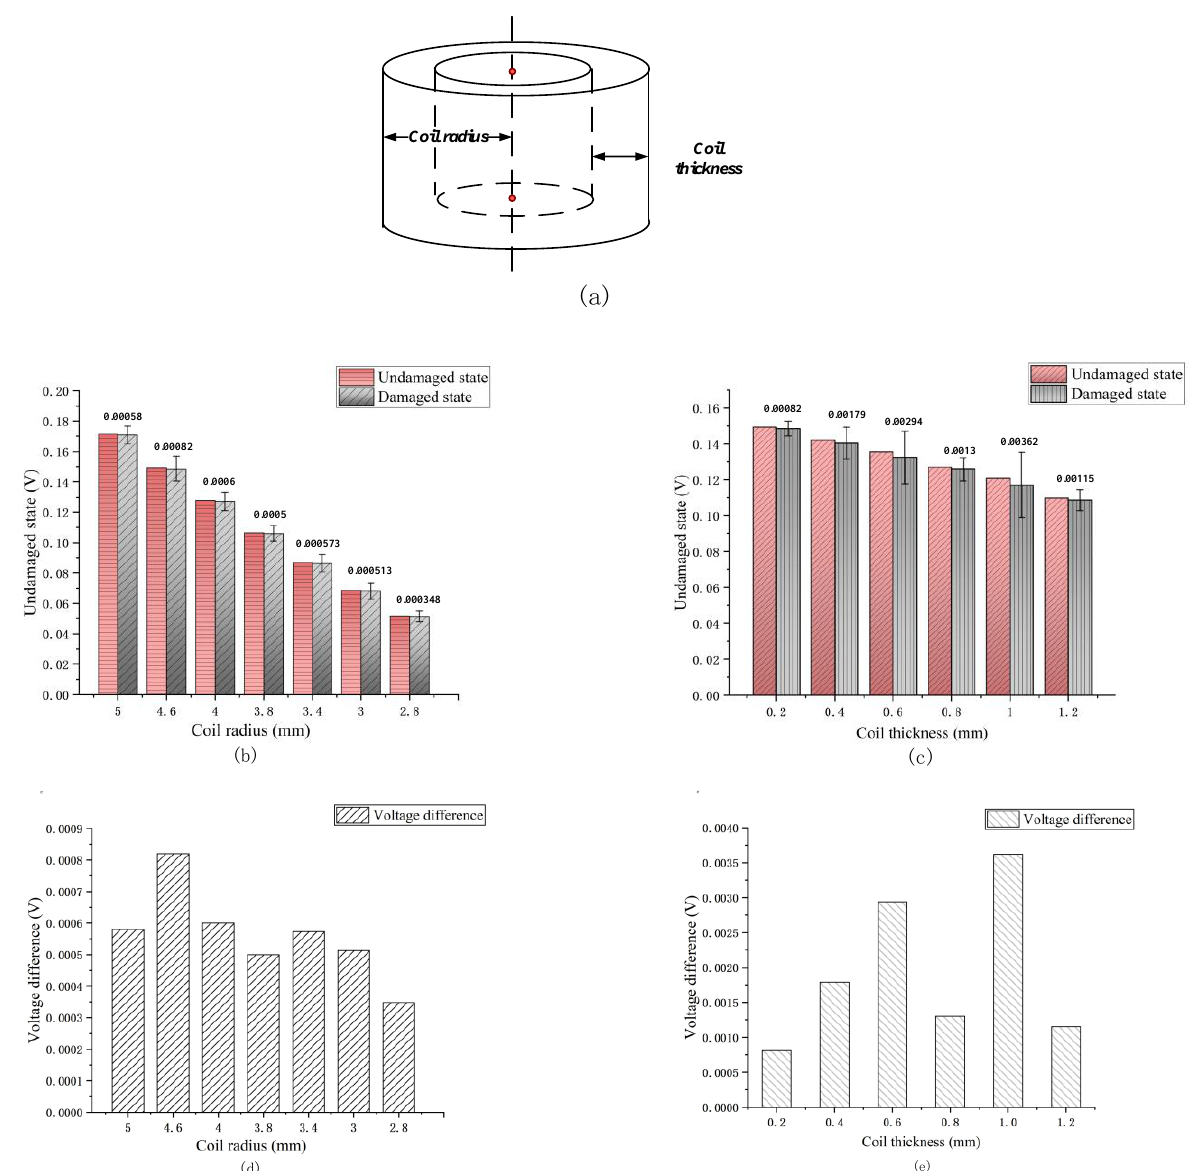
Figure 7. Coil size sensitivity test in simulation: ( a ) Schematic diagram of coil optimization parameters; ( b ) collecting coil radius optimization test; ( c ) coil thickness optimization test; ( d ) histogram of voltage difference with the change of coil radius; and ( e ) histogram of voltage difference as the thickness of the coil changes.